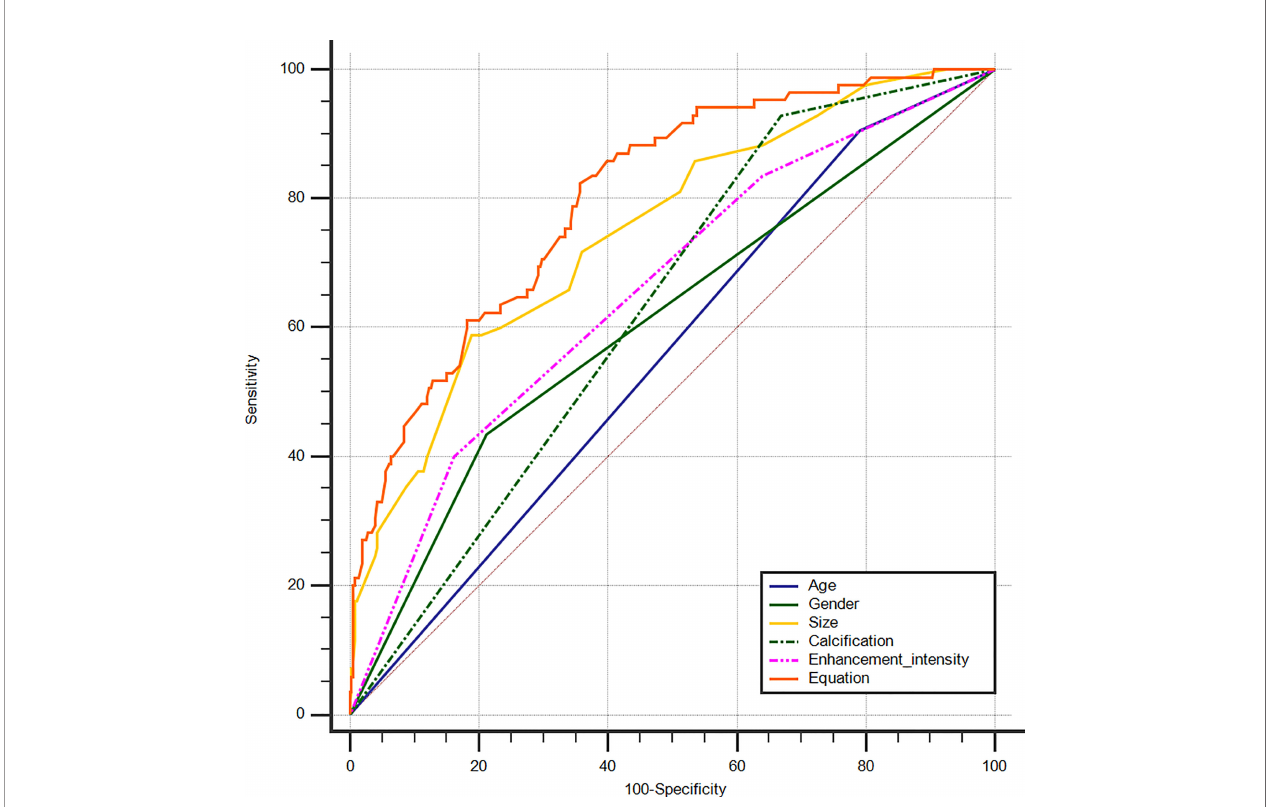
FIGURE 3 | ROC curves of PTC age (AUC=0.557), gender (AUC=0.612), size (AUC=0.749), calci fi cation (AUC=0.630), enhancement intensity on CEUS (AUC=0.658) and Equation (AUC=0.802) for the prediction of cN1. ROC, receiver operating characteristic; PTC, papillary thyroid carcinoma; AUC, area under the curve; CEUS, contrast-enhanced ultrasound; cN1, clinical N1.